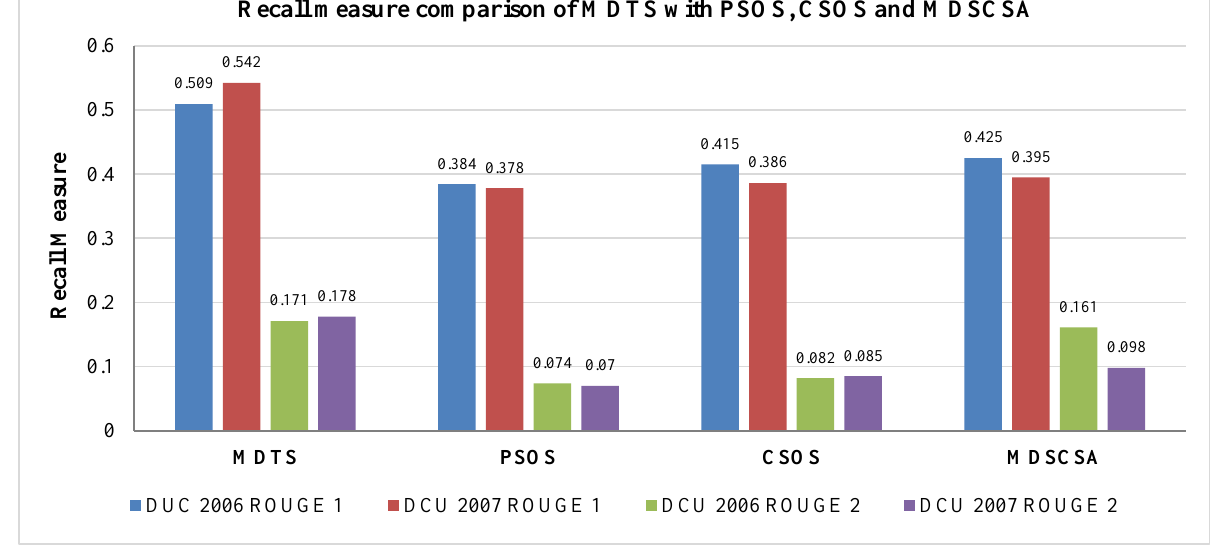
Figure 2. Comparison of Recall measure of MDTS with PSOS, CSOS and MDSCSA for DUC 2006, DUC 2007 dataset.